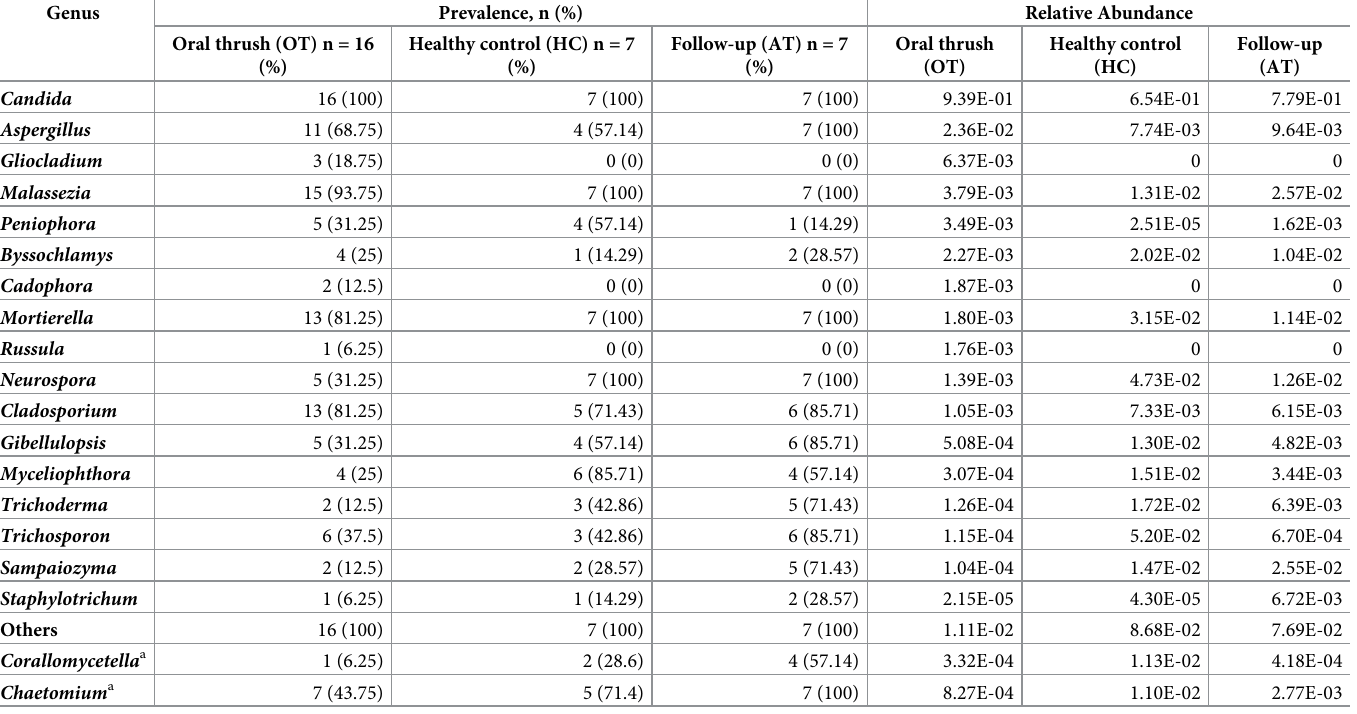
Table 4. Prevalence and relative abundance of fungi at genus level (top 10 most abundant in each patient group; arranged from highest to lowest genera relative abundance in OT